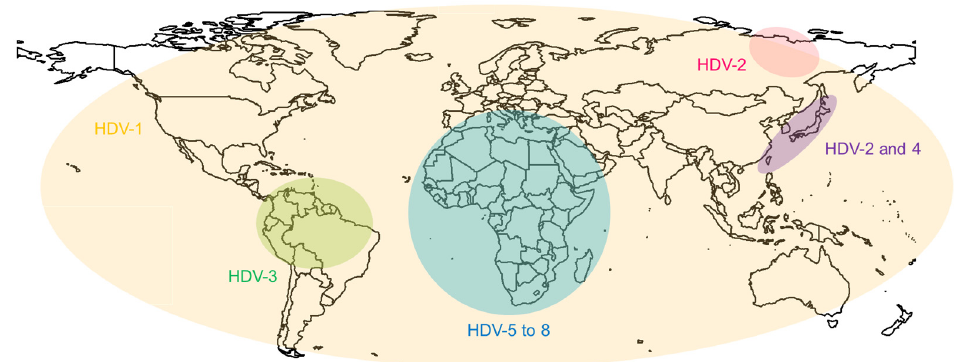
Figure 2. Global distribution of HDV genotypes. Genotype 1 is spread globally. Genotypes 2 and 4 are found in Taiwan and Japan. Genotype 2 is also found in parts of Russia. Genotype 3 dominates in the Amazon region. Genotypes 5 to 8 are located on the African continent.